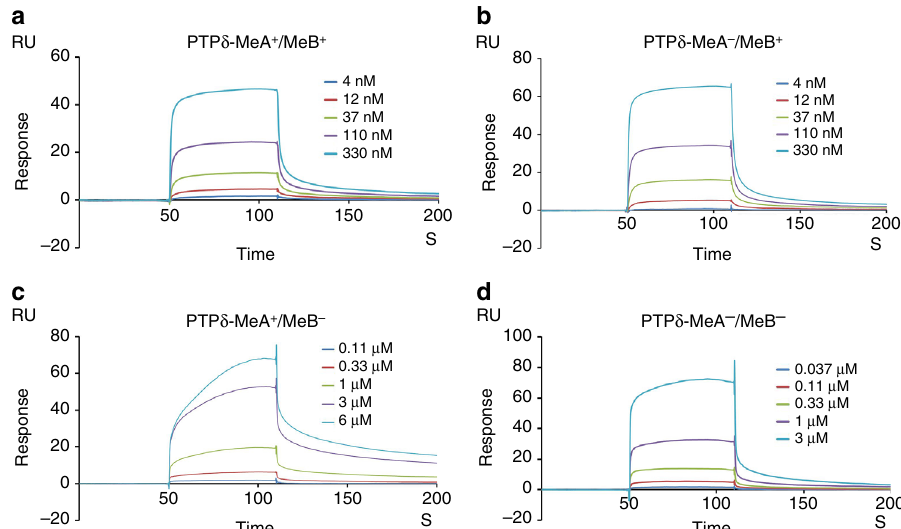
Fig. 5 SPR analysis of SALM5 interacting with PTP δ splice code variants. a – d are SPR sensorgrams of immobilized human SALM5 LRR-Ig binding to human PTP δ Ig1 – 3 WT ( a ) as well as vairants MeA − ( b ), MeB − ( c ) and MeA − /MeB − ( d ). For clarity, human PTP δ Ig1 – 3 is labeled as “ PTP δ . ” For each analyte, fi